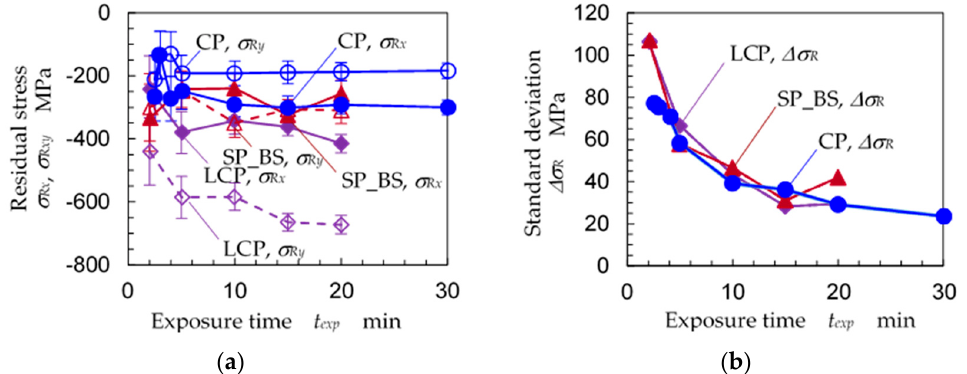
Figure 14. Effect of exposure time t exp on the residual stress measurements of stainless steel under the 2D method ( d col = 0.146 mm, ∆ ω = 8°); CP: specimen A, LCP: specimen B, SP_BS: specimen C. ( a ) Residual stress; ( b ) standard deviation of residual stress.